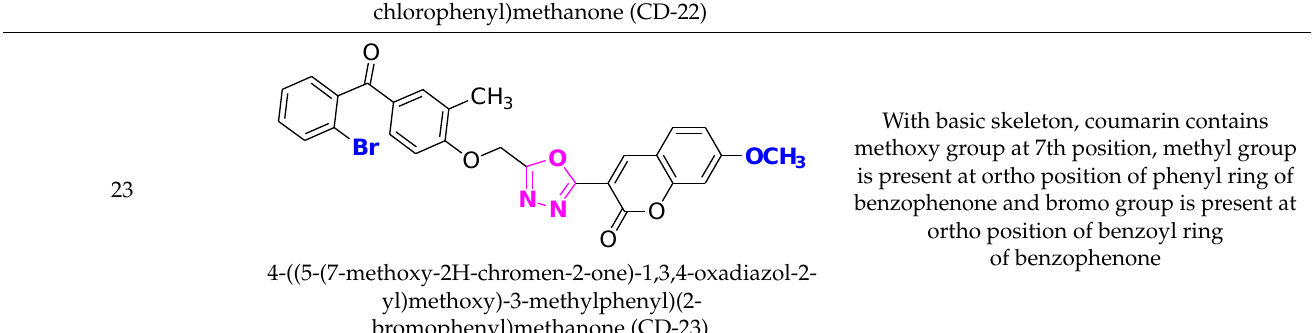
3-methylphenyl)(2-methylphenyl)methanone (CD-24)